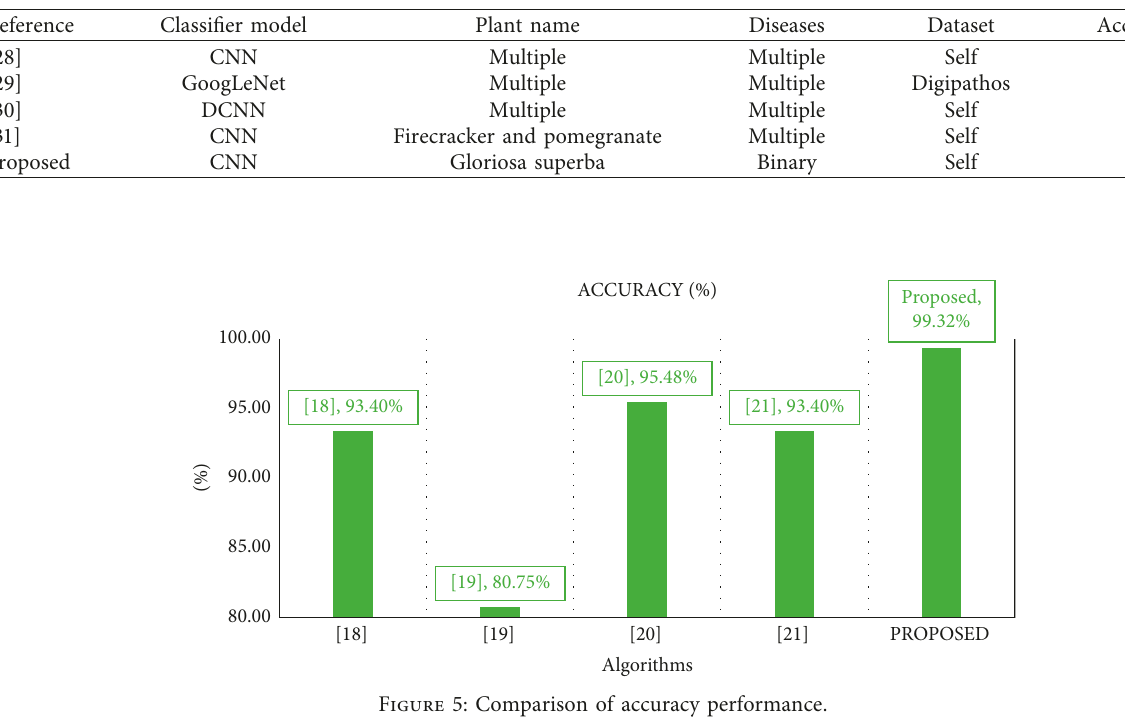
Table 6: Comparison of performance analysis of proposed with the existing method.